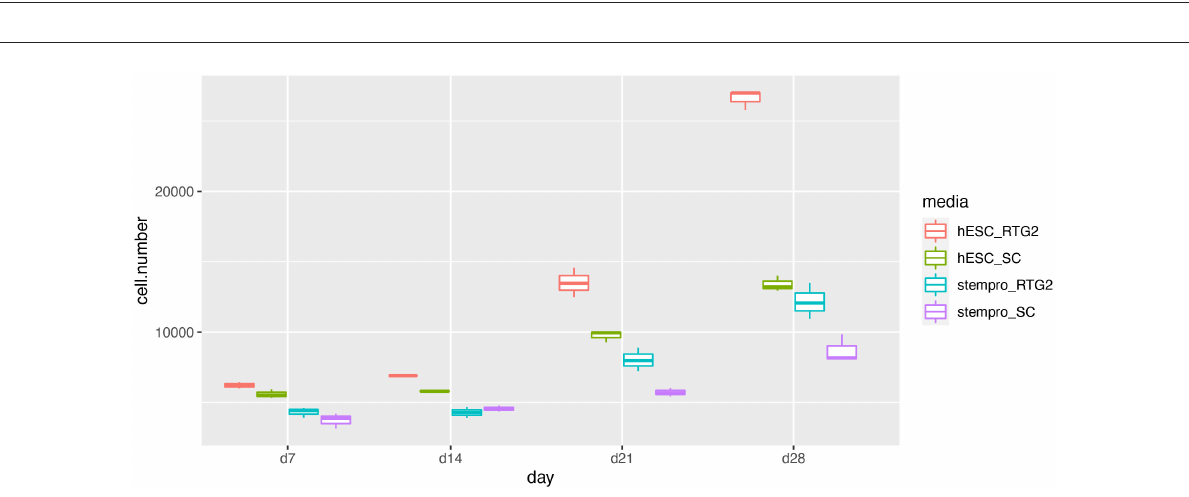
FIGURE2 Effects of somatic cells on mitotic activity of common carp germ cells. The figure shows mean ± SEM ( n = 3) of total germ cell number under hESC and stempro media with RTG2 and Sertoli cell line (SC). Cell number was count on days 7, 14, 21 and 28 of culture. Data are shown as the mean ± SEM ( n =